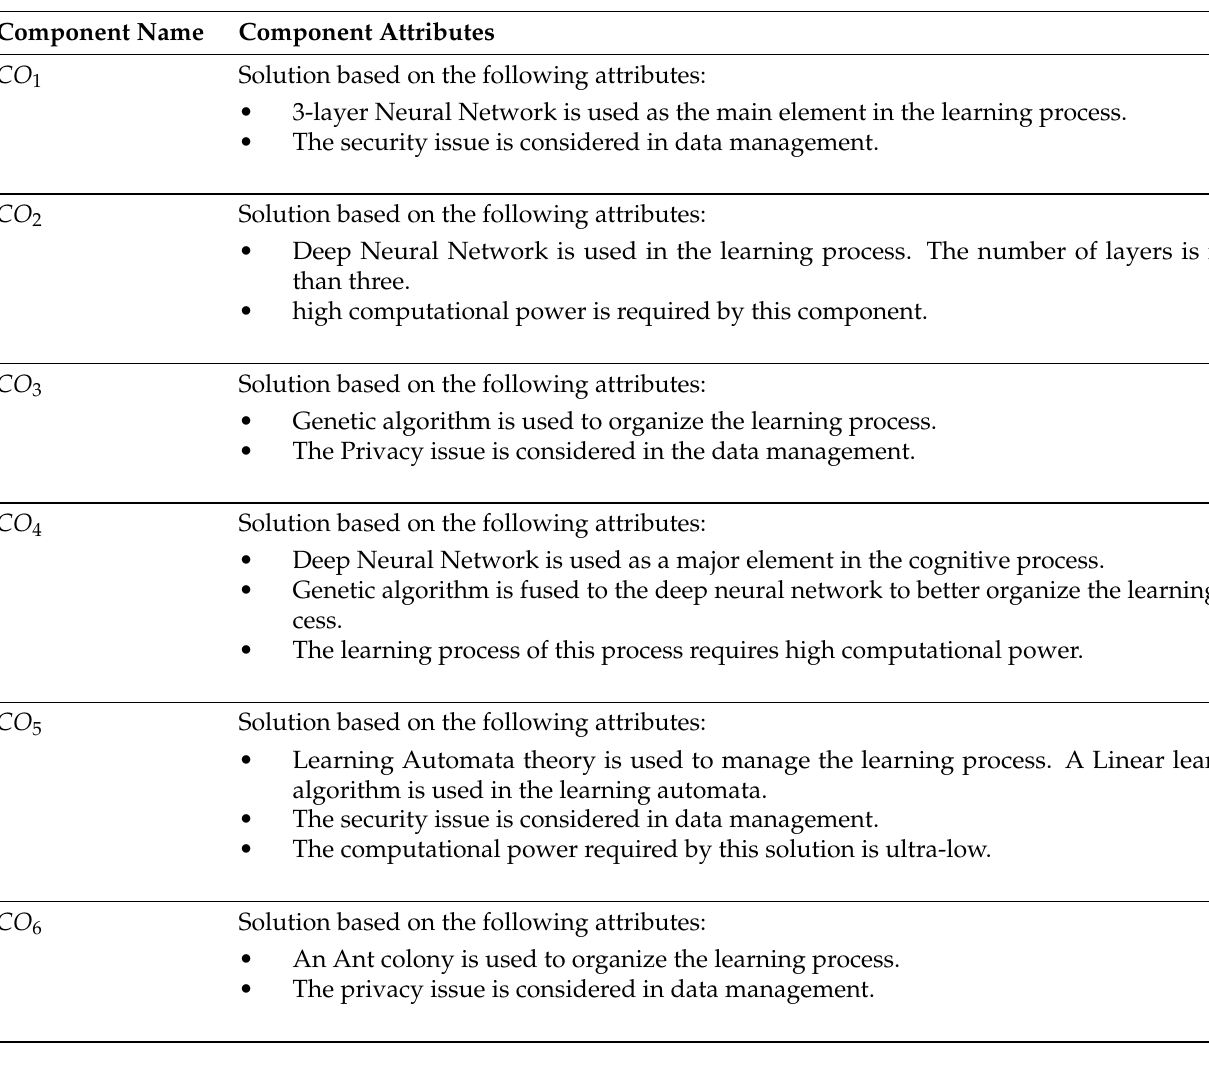
Table 4. Components’